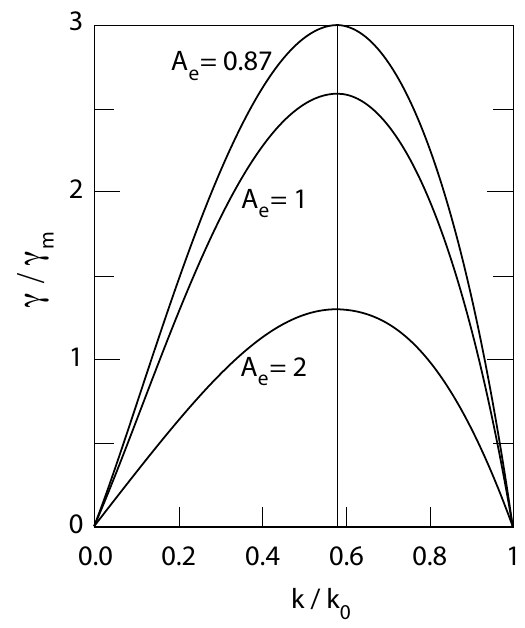
Fig. 1. The anisotropic-thermal Weibel instability growth rate γ/γ m , normalised to maximum growth, as function of the nor- malised wavenumber k/k 0 for three different thermal anisotropies. This ratio increases as A − 1 . The vertical line indicates the position of the maximum growing wave number k m /k 0